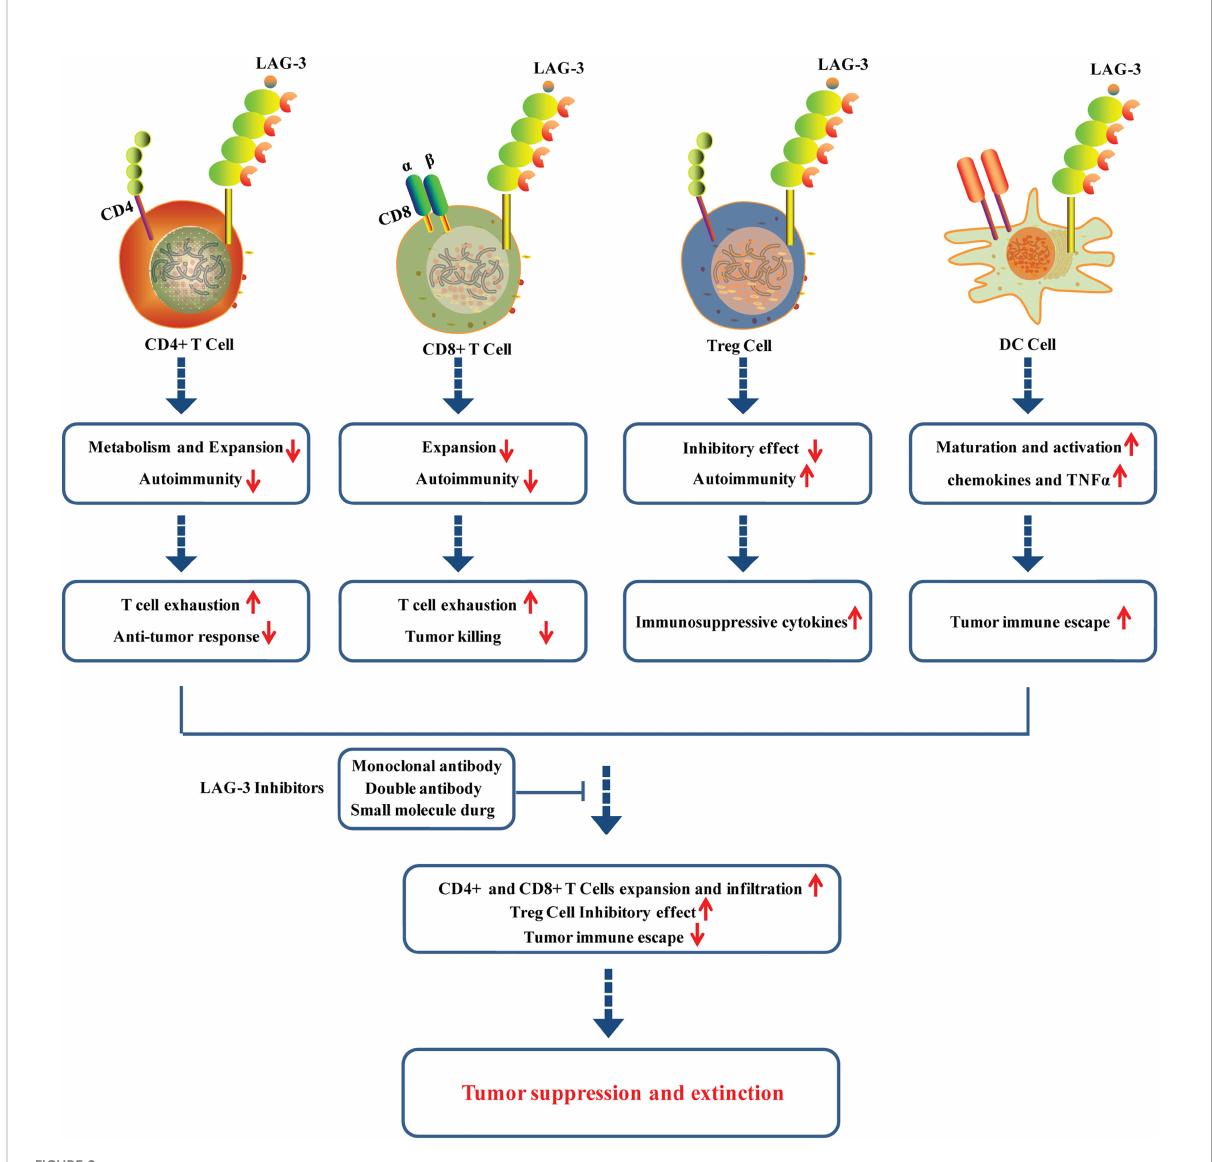
FIGURE 2 Roles of LAG-3 in CD+4 cells, CD8+ cells, Treg cells and DC cells in tumor